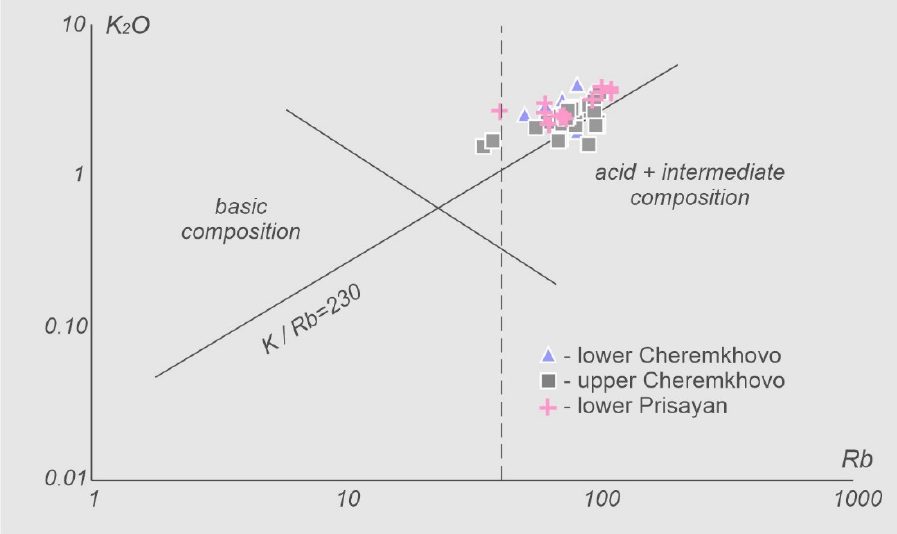
Figure 14. The Rb versus K 2 O plot (after [50] ).